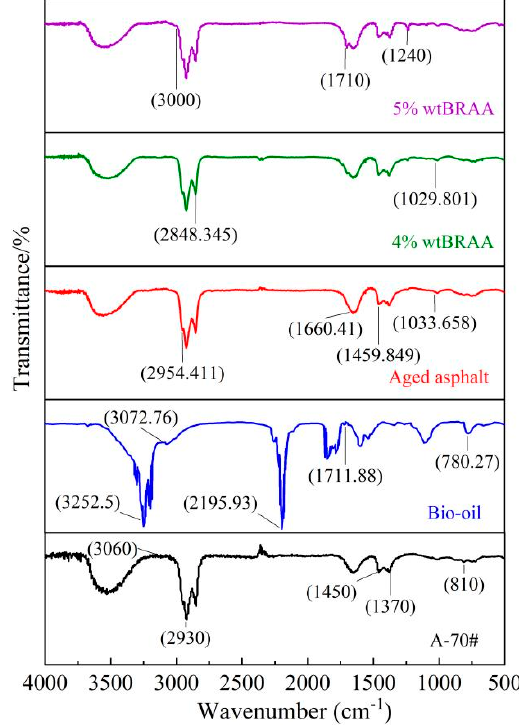
Figure 4. FTIR spectroscopy of the soybean oil.